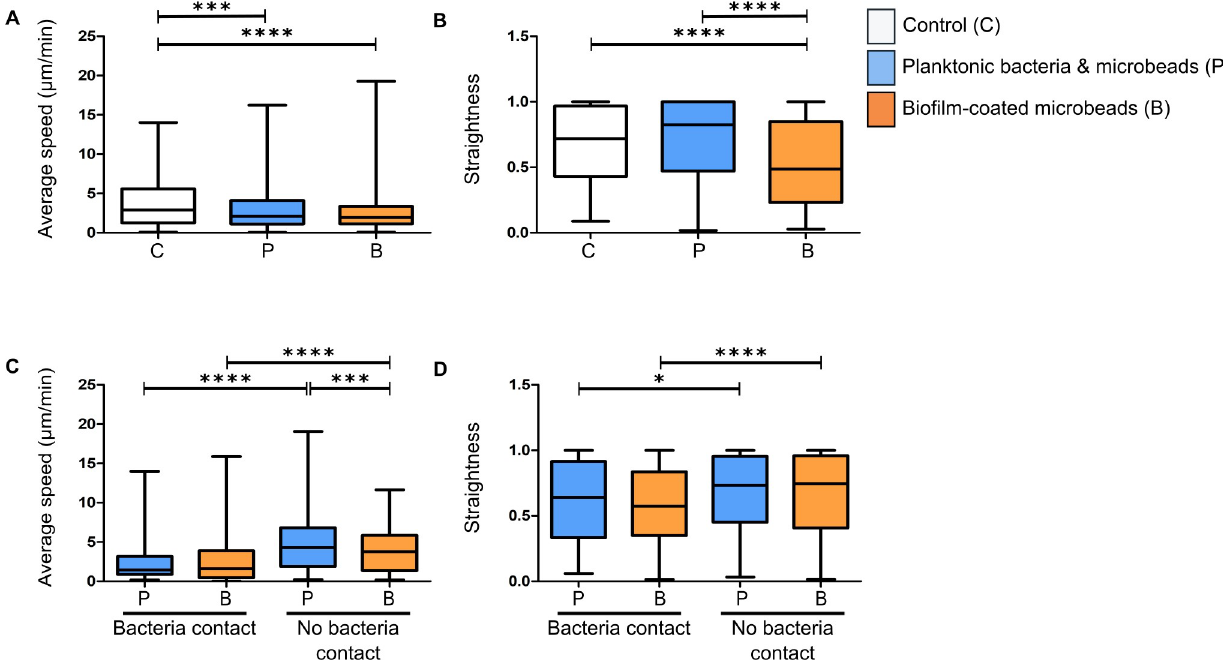
Fig 6. Analysis of average speed and straightness of innate immune cells in the mouse ear pinna. Average speed (A and C) and straightness (B and D) of EGFP+ cells recruited to injection sites at early time points after microinjection of PBS (control), planktonic bacteria and microbeads, or biofilm-coated microbeads. Data are expressed as median and interquartile ranges pooled from three different mice in three independent experiments for each group. Average speed (A) and straightness (B) of all cells (in contact with visible bacteria or not) in infected and control mice. Number of cells (N) analysed for each group at early time points: Control: N = 190 cells; Planktonic form: N = 721 cells; Biofilm form: N = 771. Average speed (C) and straightness (D) of cells either in contact (bacteria contact) or not (no bacteria contact) with planktonic or biofilm bacteria at early time points. Number of cells (N) analysed at early time points that were in contact or not in contact with bacteria, respectively: Planktonic form: N = 238 and 386 cells; Biofilm form: N = 433 and 276 cells. p � 0.05 was considered statistically significant (symbols: ���� p � 0.0001; ��� p � 0.001; �� p � 0.01; � � 0.05; ns = non-significant).